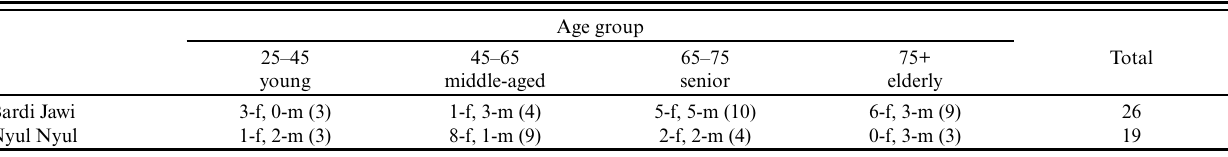
Table 2 . Age and gender of participants interviewed (female: X-f, male: